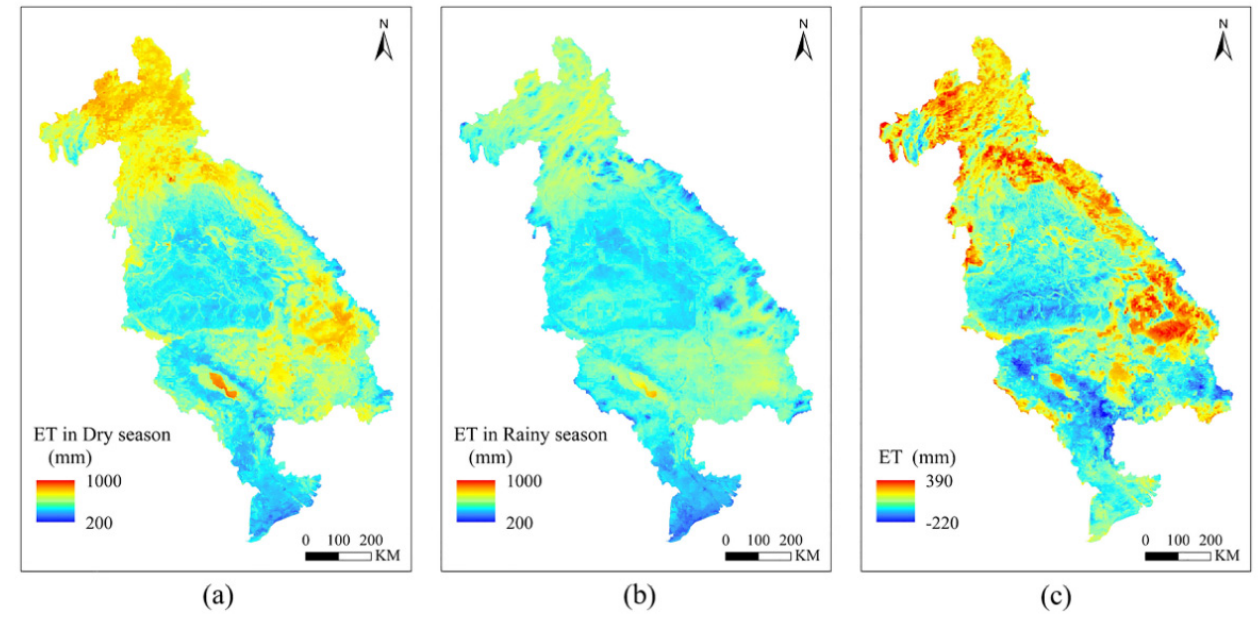
Figure 8. Spatial distribution of seasonal ET from 2008 to 2017 ( a ) Dry season ET; ( b ) Rainy season ET; ( c ) Spatial distribution of the ET difference between rainy and dry seasons.